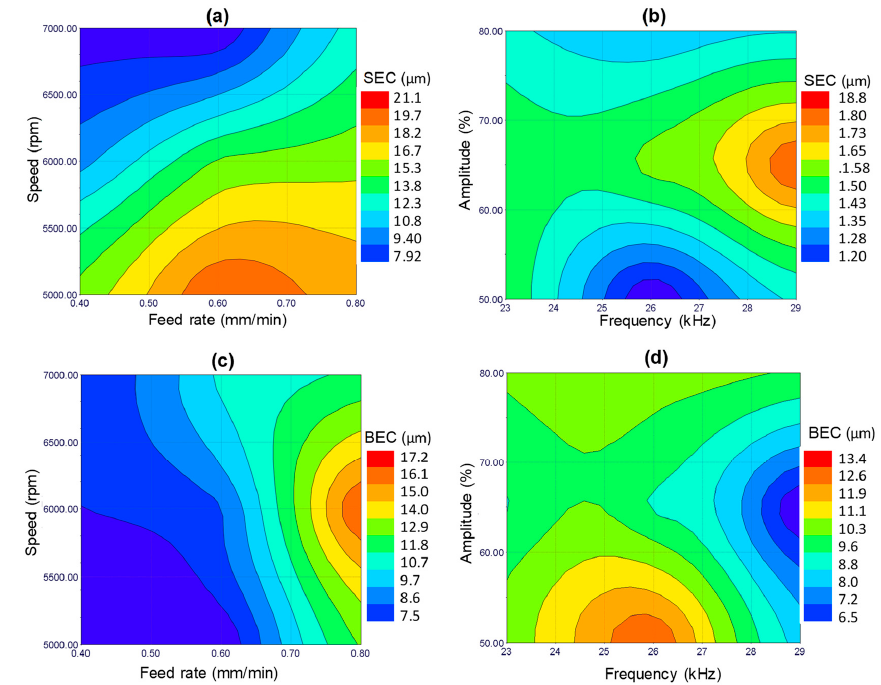
Figure 13. A comparison between entrance and exit edge chipping: ( a ) a typical micrograph of side edge chipping; ( b ) a typical micrograph of bed edge chipping; ( c ) edge chipping at the tool exit; and ( d ) edge chipping at the tool entrance edge.